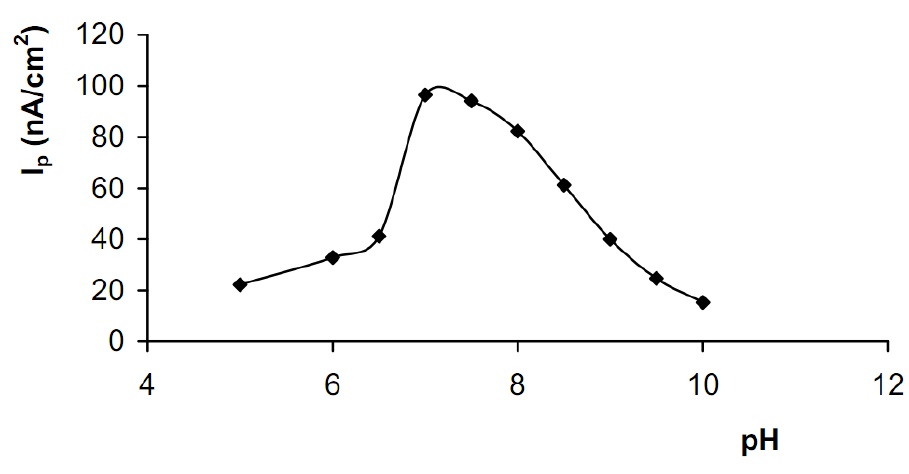
Figure 4. The effect of pH on the biosensor response (2.0 × 10 −4 M ethanol, T: 25 °C, detection: DPV, scan rate: 15